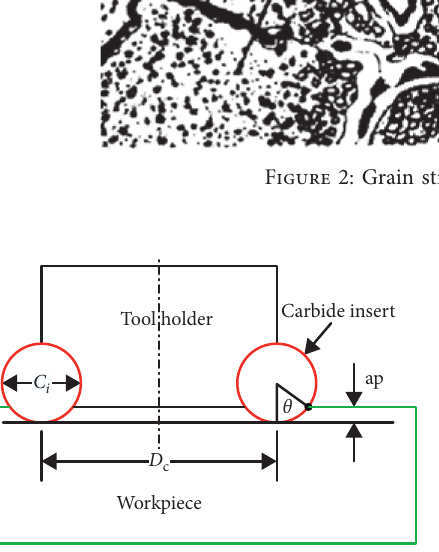
Figure 3: Geometry and labeling of a cutting